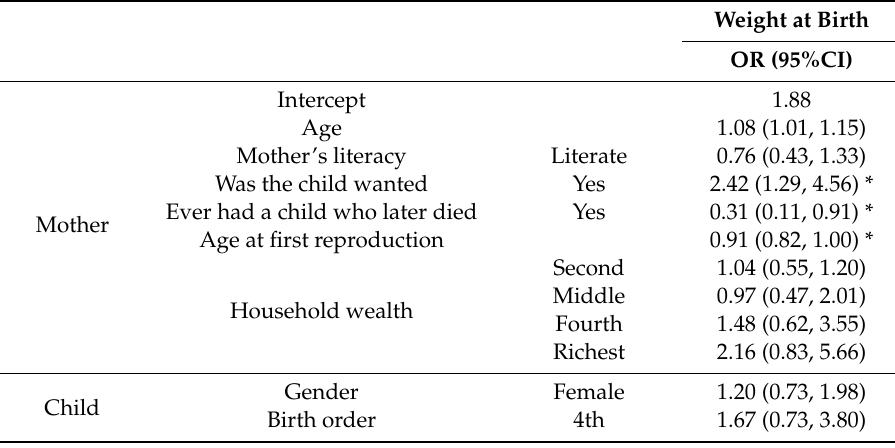
Table 2. Predictors of low birthweight.